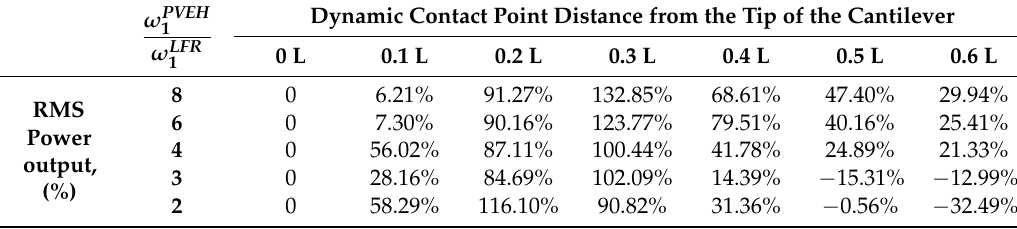
Table 6. Comparison between tandem power output at different positions of contact point and a contact position at the tip.